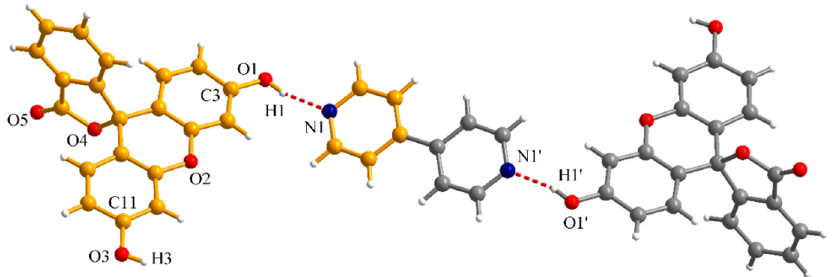
Figure 1. Crystal structure of 1 . The asymmetric unit is depicted in orange. Symmetry code: ’ = 1 − x, 1 − y, − 1 − z.